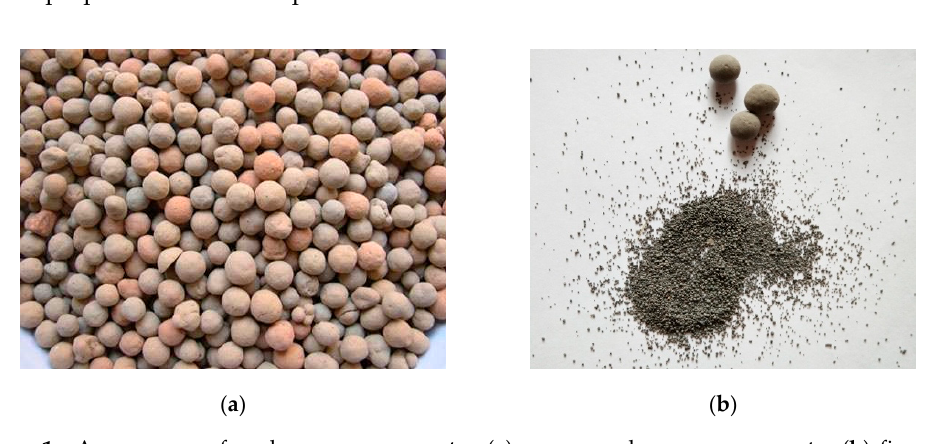
Figure 1. Appearance of coal gangue aggregate: ( a ) coarse coal gangue aggregate; ( b ) fine coal gangue aggregate. Table 4. Physical properties of single-particle gangue.